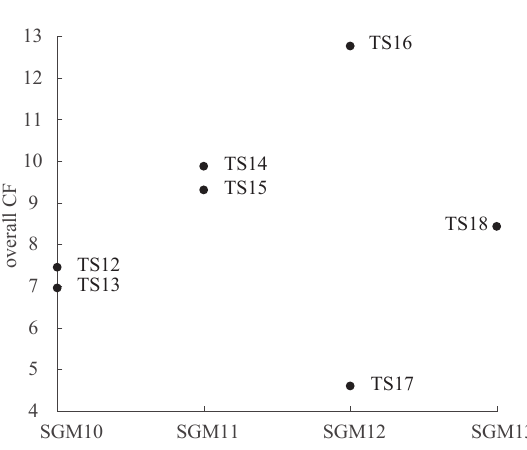
Figure 14. Overall CF values of the instantaneous phases of all the available turbines in the same time